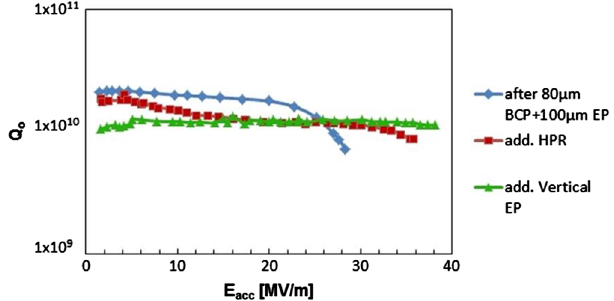
FIG. 32. Q (Eacc) performance of the two-cell hydroformed o cavity 2H3. Vertical EP done at Cornell University by A. Crawford.